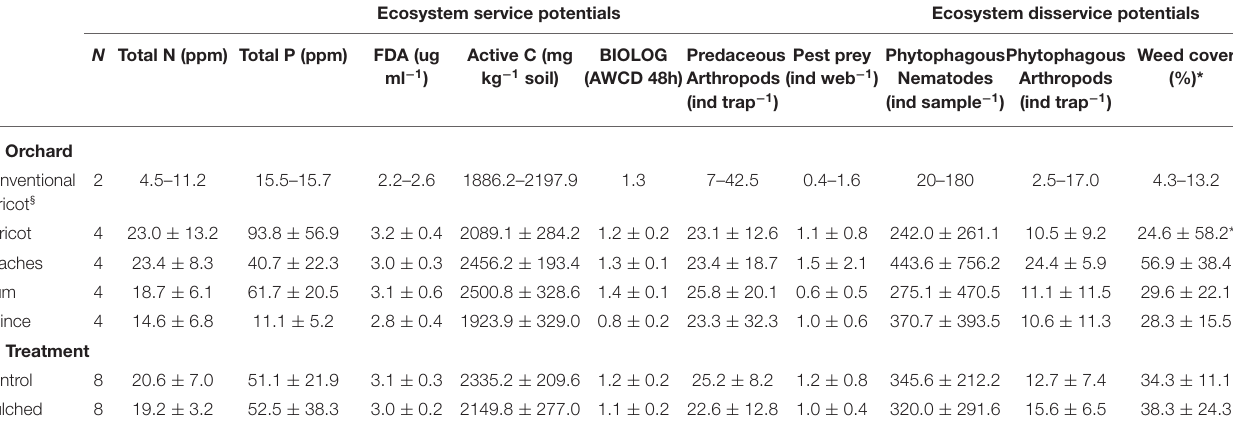
TABLE 4 | Mean values of ecosystem service [Total N, Total P, microbial activity (FDA, Active C and BIOLOG), predaceous arthropods, and pest prey] and disservice (phytophagous Nematodes, phytophagous Arthropods, and weed cover) potentials ± 95% confidence intervals of the mean in (A) different orchards and (B) control or mulched